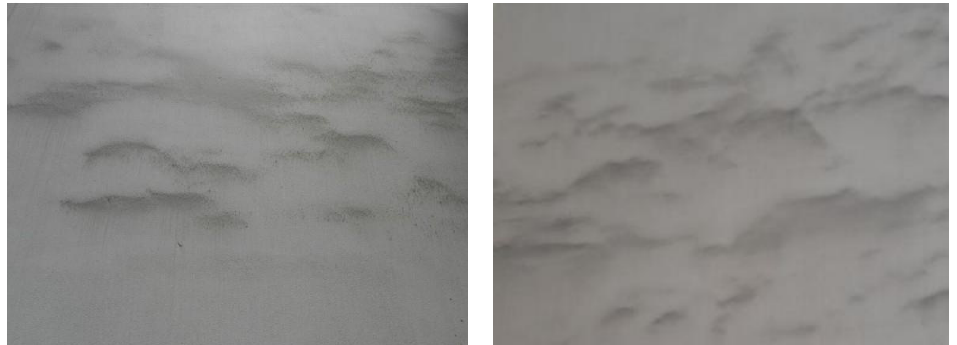
Figure 1. Contaminated exterior wall paints in a typical western city in China, Chongqing.